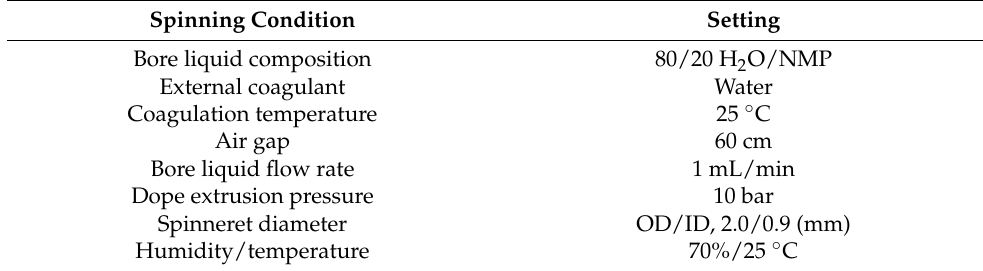
Table 1. Spinning conditions and parameters. Spinning Condition Setting Bore liquid composition 80/20 H 2 O/NMP External coagulant Water Coagulation